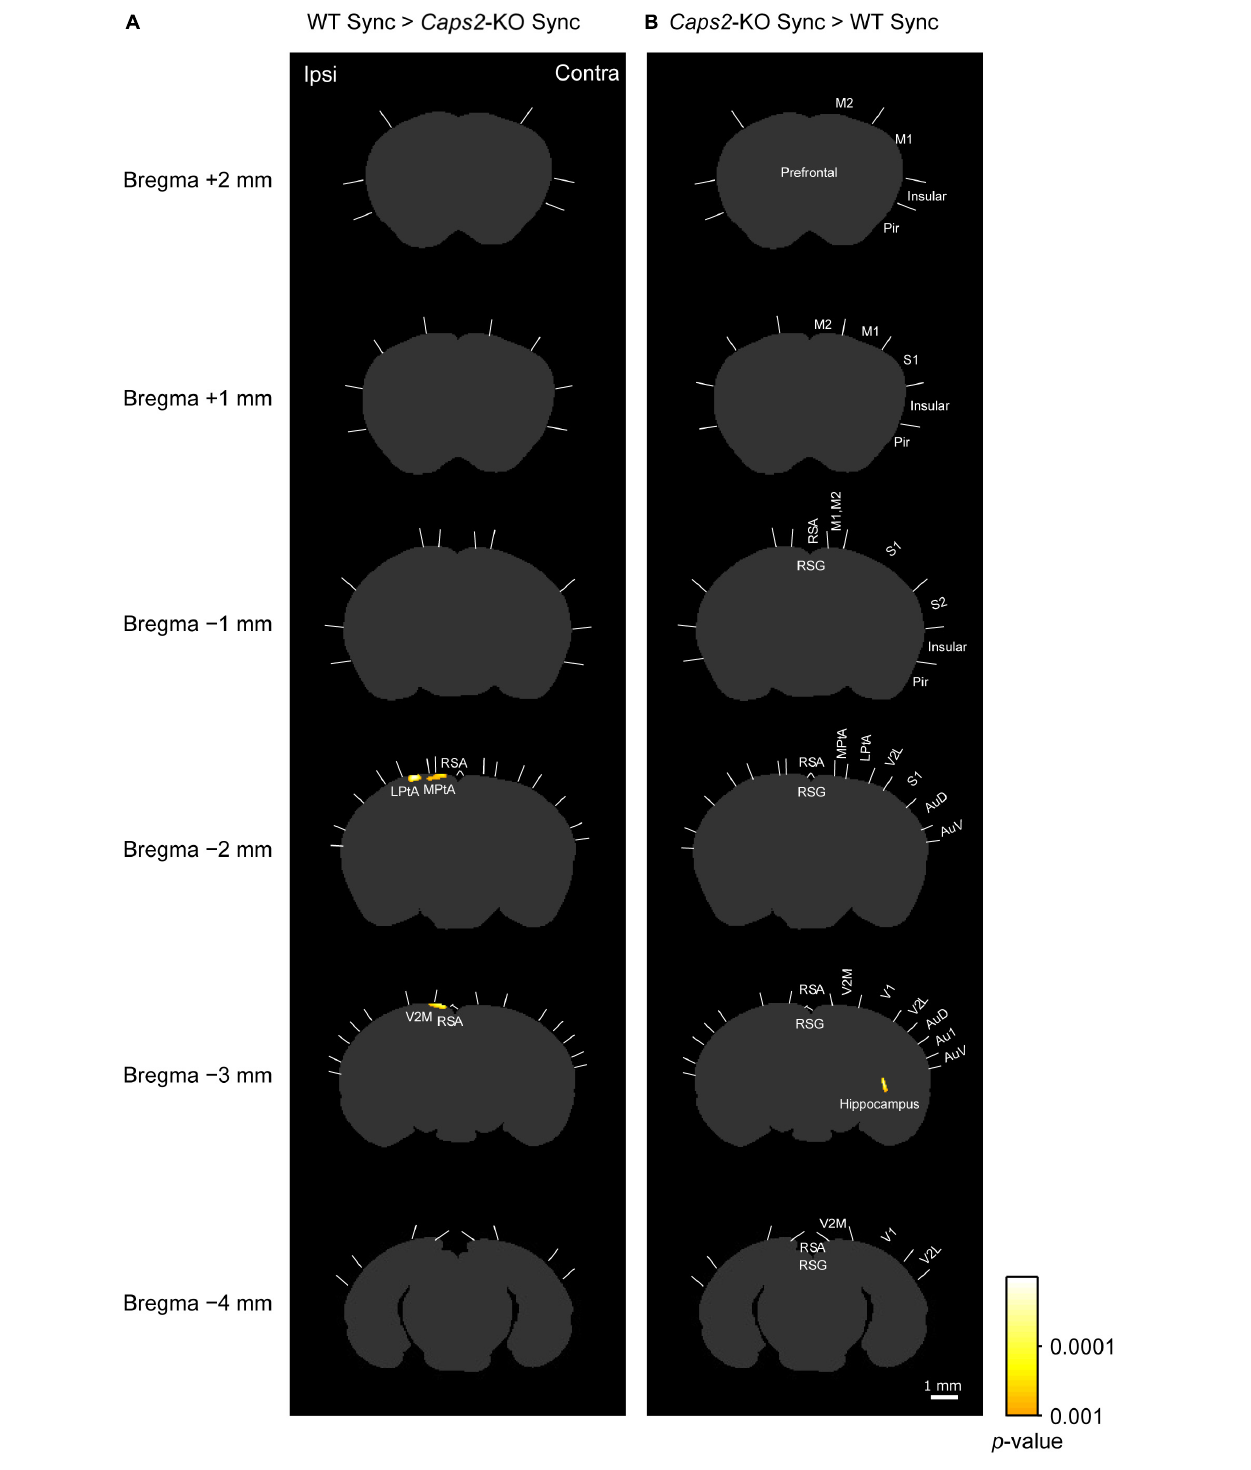
FIGURE 3 | c-Fos imaging (statistical parametric mapping): Comparison between WT and Caps2 -KO mice exposed to synchronous stroking. (A) Areas that showed significantly higher densities of c-Fos-positive cells in the WT mice exposed to the synchronous condition than in the Caps2 -KO mice exposed to the synchronous condition after correcting for multiple comparisons at the cluster-level threshold ( p < 0.05). Pixel-by-pixel t -tests were applied between two groups. (B) Areas that showed significantly higher densities of c-Fos-positive cells densities in the Caps2 -KO mice exposed to the synchronous condition than in the WT mice exposed to the synchronous condition after the cluster level control. Boundaries between regions were determined by reference to the brain atlas (Paxinos and Franklin, 2001). Scale bar: 1 mm.